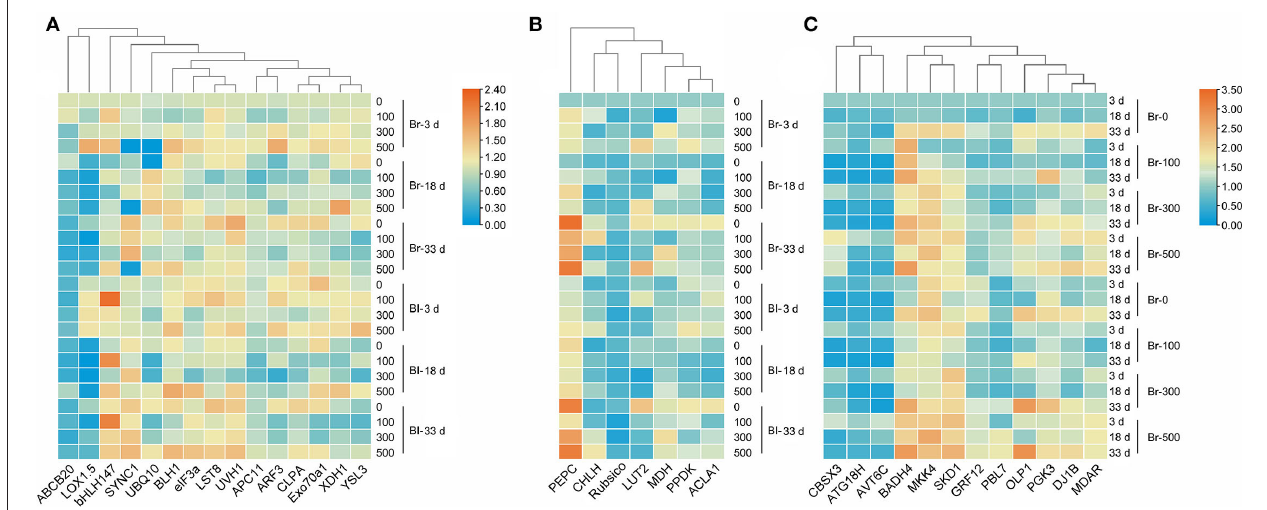
FIGURE 13 | Heatmap of fold expression of 34 TDFs expressed in seedlings of S. aralocaspica at different developmental stages under salt stress. (A) Development-related genes, (B) photosynthesis-related genes, and (C) salt stress response genes. 3 d, 18 d, and 33 d represent 3, 18, and 33 days after seedling emergence, respectively. 0, 100, 300, 500: different NaCl concentrations (mM). Br, brown seedling; Bl, black